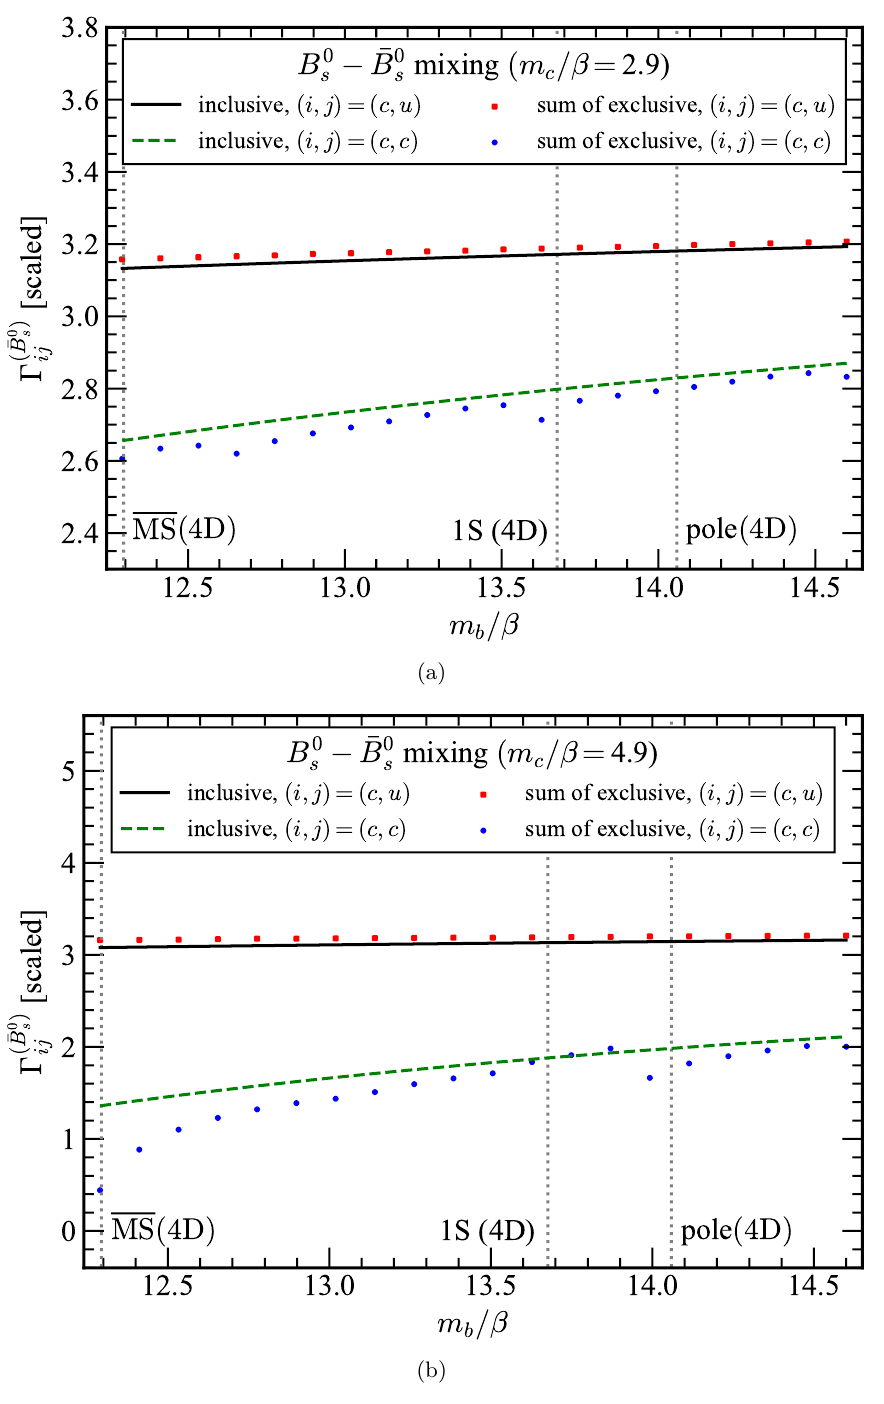
¯ mixing: (a) m − B 0 s s